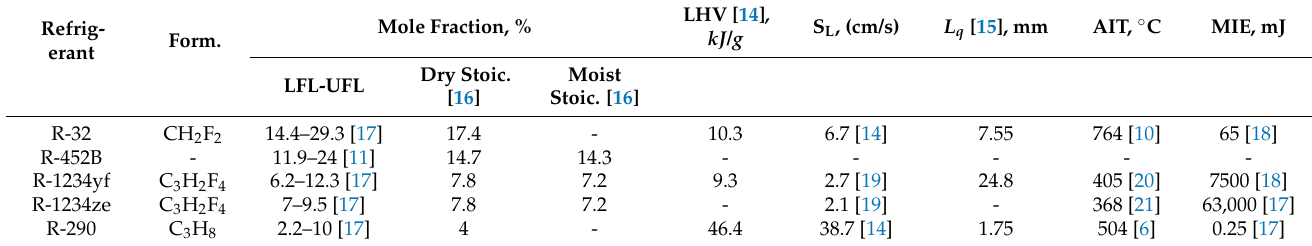
Table 1. Selected combustion properties in air of four A2L refrigerants and R-290. Refrig- erant